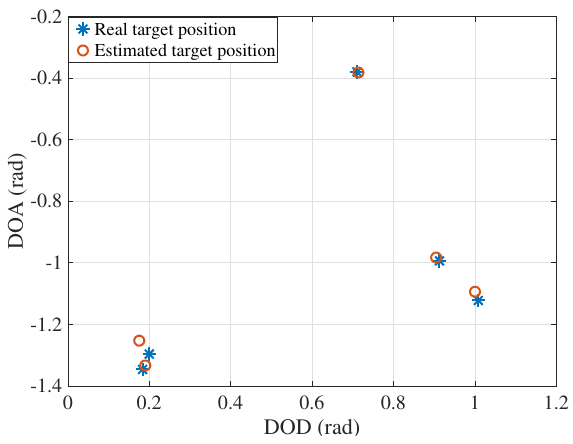
Figure 3. The estimated target